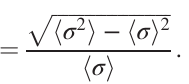
FIG. 5. Distribution of final outbreak sizes for β ¼ 0 . 003 , 0.01, 0.02, and 0.1, respectively. For β ¼ 0 . 02 and 0.1, we mark part of the distribution with outbreak sizes below the given threshold of 20% by a lighter color tone and neglect this contribution to the averaged value (blue vertical line). The expected outbreak size from MC simulations and the estimations from the CB and IB models are plotted as blue, red dashed, and green dotted vertical lines, respectively.